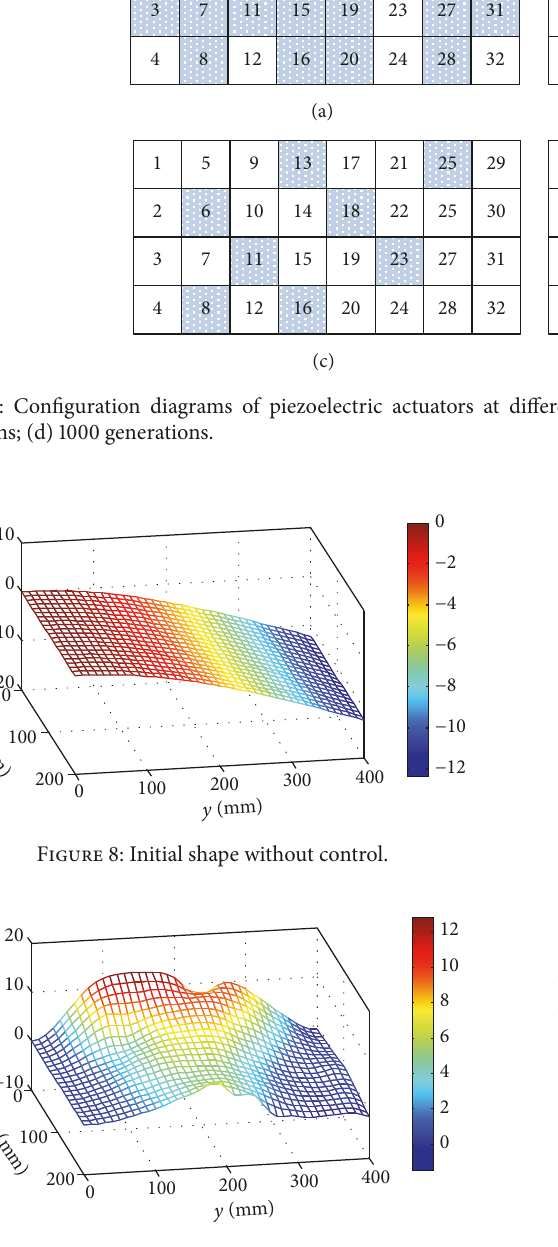
Figure 9: Controlled shape when evolution is at 125 generations.